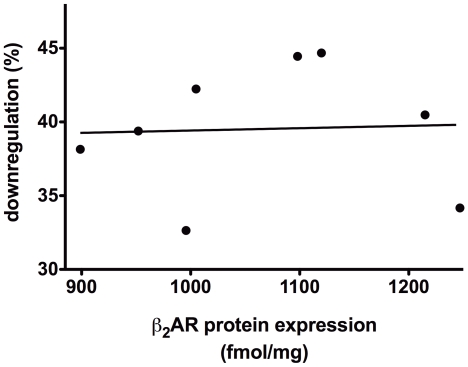
Lack of a relationship between baseline β2AR expression and the % downregulation.The agonist-promoted downregulation, expressed as a percentage, was plotted against baseline β2AR protein expression. There was no relationship (r2 = 0.001, p>0.9) between the initial expression of β2AR and the extent of downregulation. Results are from the 7 experiments of Figure 4.